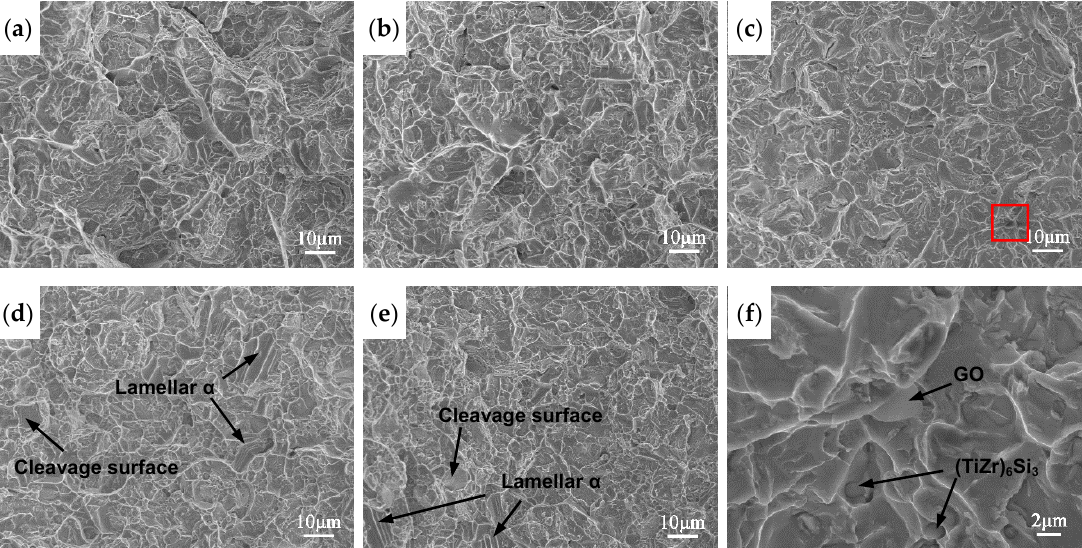
Figure 11. Tensile properties of the composites at different temperatures. ( a ) Room temperature; ( b ) 600 °C.